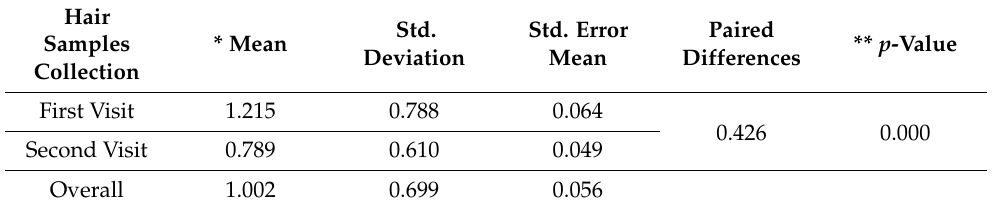
Table 2. Cortisol levels in hair at different time intervals for the participating students (N-151). Hair